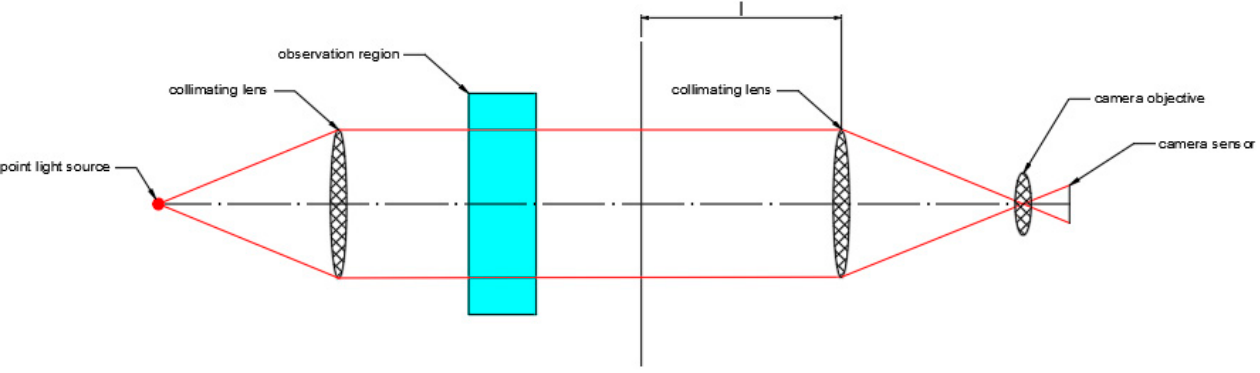
Figure 13. Basic shadowgraph layout with camera.